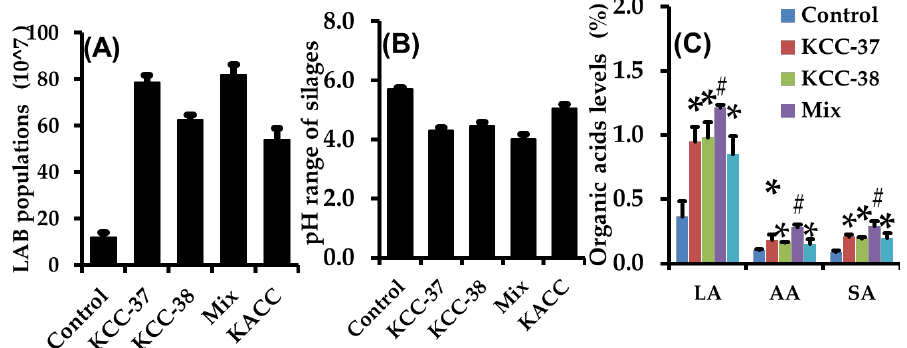
Figure 5. Microbial populations, acidification of silages and Organic acids profiles in fermented low moisture IRG silage. ( A ) Microbial population in L. plantarum KCC-37, and L. plantarum KCC-38 inoculated and non-inoculated low moisture silage; ( B ) pH of the low moisture silages ( C ) organic acids including lactic acid (LA), acetic acid (AA), succinic acid (SA) in the experimental silages. Data represent the mean ± STD ( n = 3), * Significance between treated and untreated group at p < 0.05 level. # Significance between the mixed culture treated, single culture treated and control groups at p < 0.05 level.